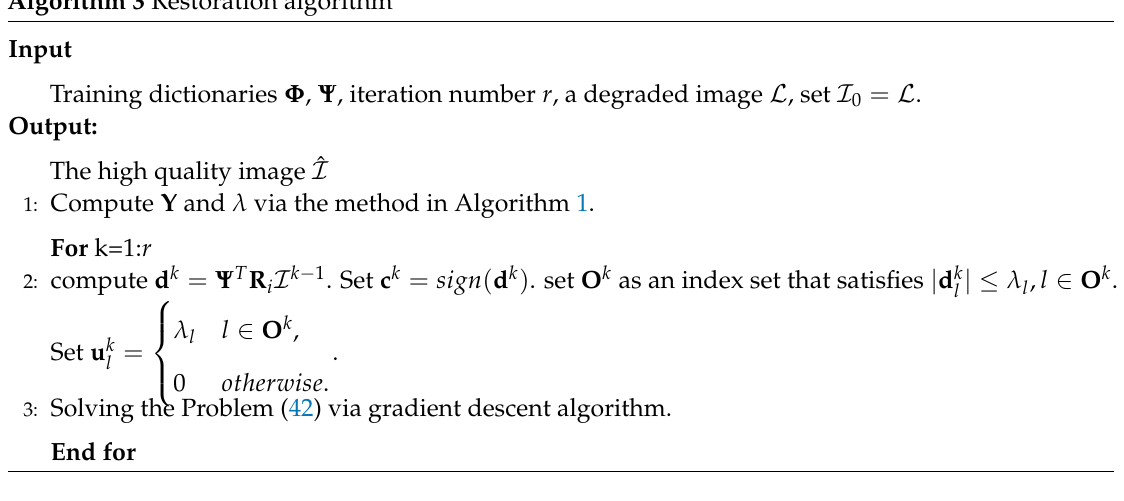
Algorithm 3 Restoration